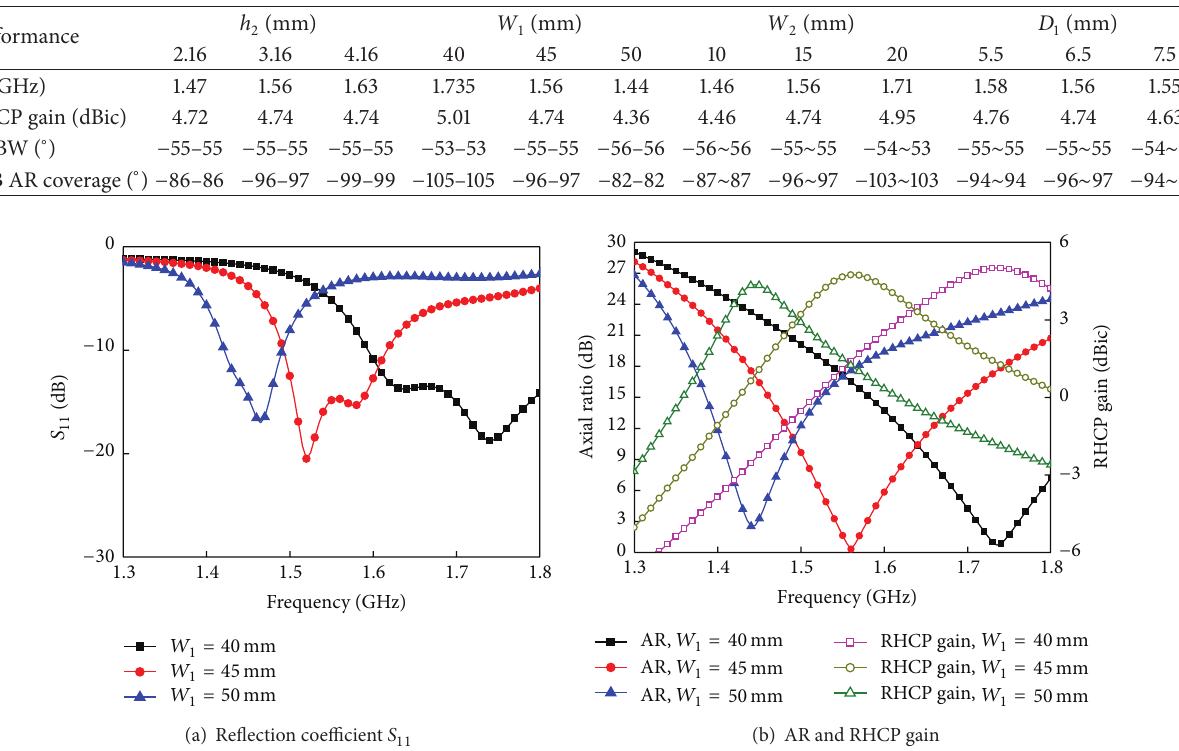
, W , W , and D on the center operating frequency, HPBW, and 3 dB beamwidth of the antenna. 2 1 2 1